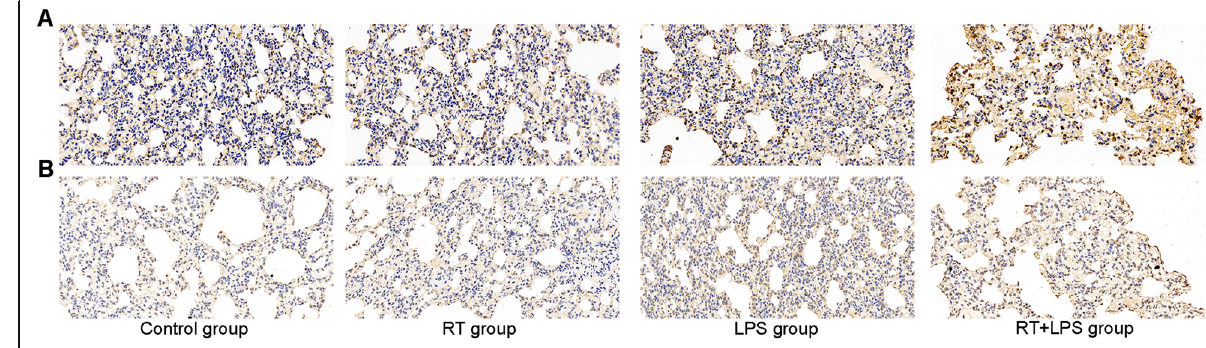
Fig. 4 Immunohistochemical stains for PKM2 ( a ) and GLUT1 ( b ) in tissues from the right lungs of rats in the control, radiotherapy (RT)-only, lipopolysaccharide (LPS)-only, and RT+LPS groups